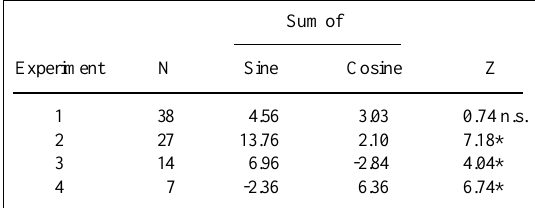
Table II - Rayleigh test for the data in Table I.